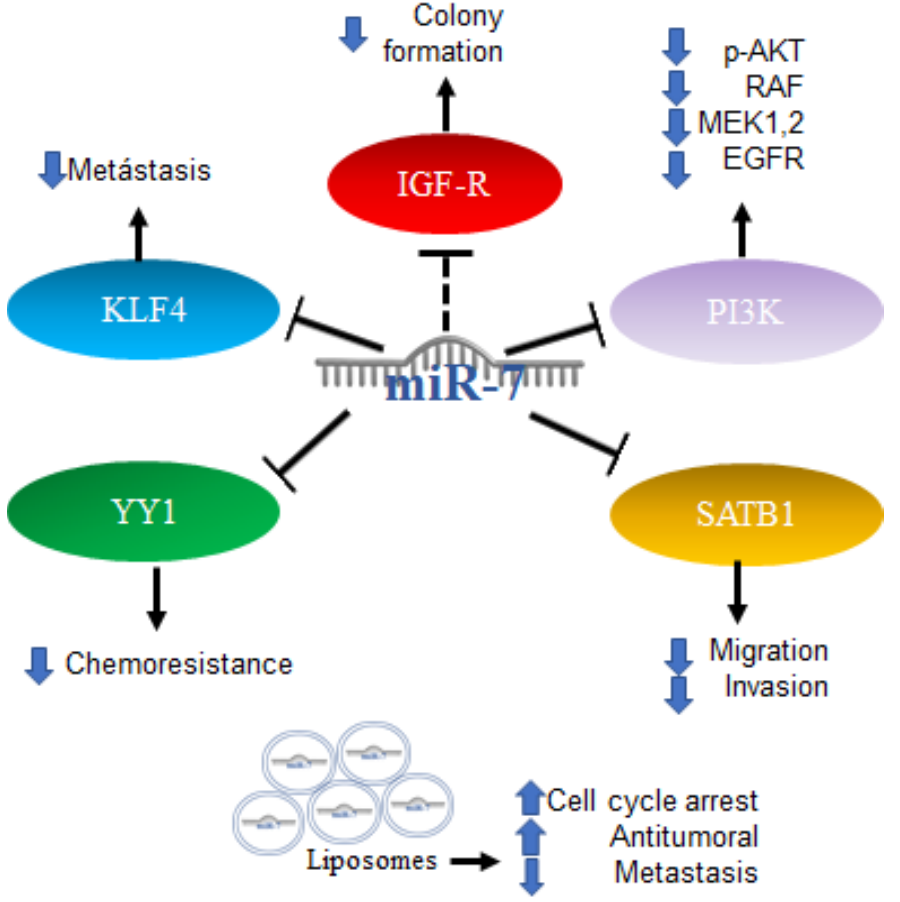
Figure 6. Role of miR-7 in gliomas. Schematic representation of protein interactions, roles and treatment with miR-7 and its biological consequences in gliomas.